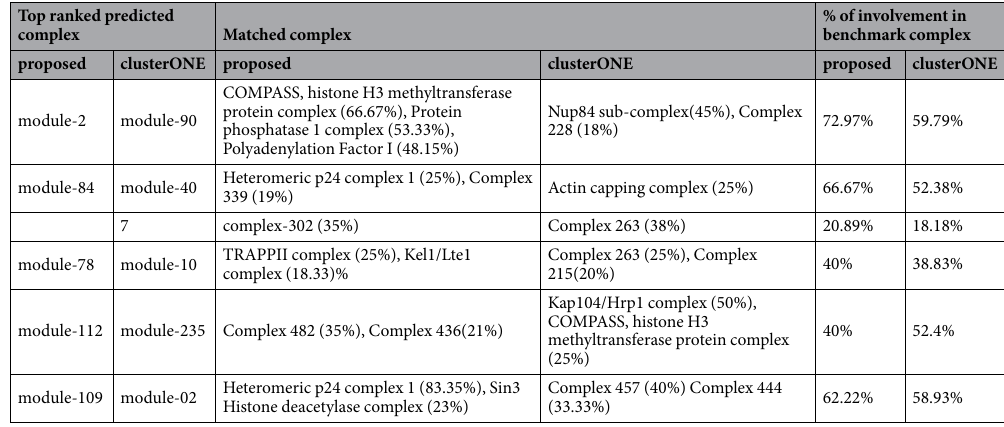
Table 5. Table shows the comparison of top rank five predicted complexes of proposed and clusterONE method. Second column represents benchmark complexes detected by the methods. Third column represents proportion of proteins that are involved in some benchmark complexes.